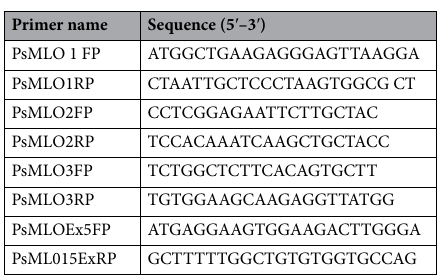
Table 6. List of primers used for cDNA amplification of pea